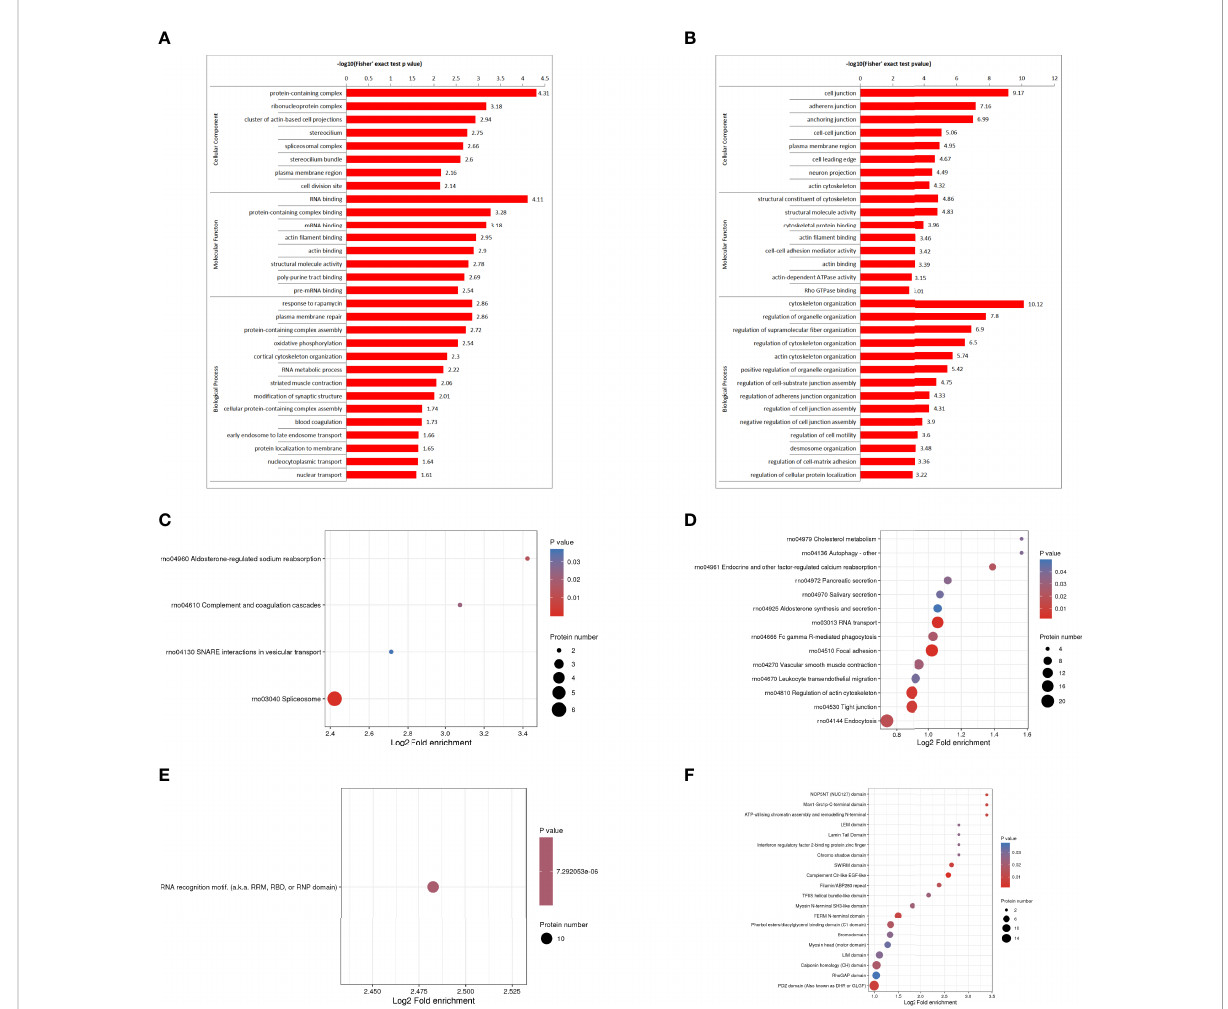
FIGURE 8 Functional enrichment analysis of DDPs. GO enrichment, up-regulated differentially phosphorylated protein enrichment (A) . GO enrichment, down-regulated differentially phosphorylated protein enrichment (B) . KEGG enrichment of up-regulated differently phosphorylated proteins (C) . KEGG enrichment of down-regulated differently phosphorylated proteins (D) . Enrichment of important protein domains in up-regulated differentially phospho-proteins (E) . Enrichment of important protein domains in down-regulated DDPs (F)